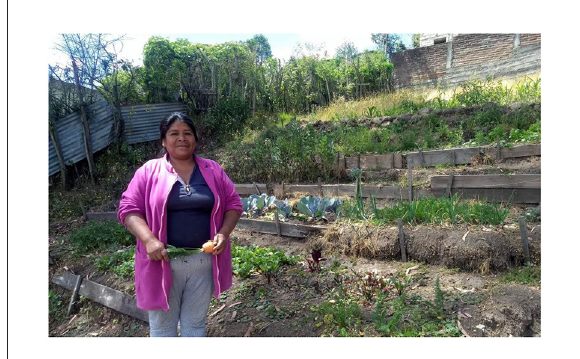
FIGURE7 Woman urban farmer of AGRUPAR’s project. Photo: Carrasco-Torrontegui